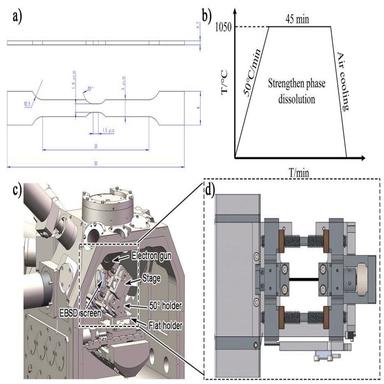
Sample preparation and in-situ tensile experiment. a) size of Inconel 718 alloy sample; b) heat treatment scheme; (c-d) in-situ tensile system.